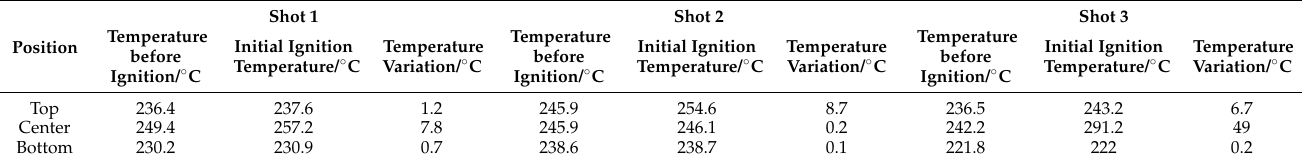
Table 3. Response characteristics of